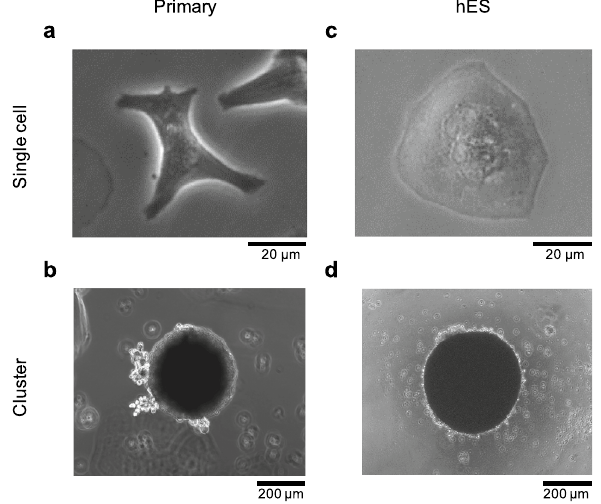
Figure 2. Micrographs of single cells and clusters of mouse primary and hES-derived cardiomyocytes. ( a ) Mouse primary cardiomyocytes (primary) in a 35-mm non-agarose-coated dish (single cell), ( b ) primary cells in a 24-well agarose-coated plate (cluster), ( c ) hES cardiomyocytes in a 35-mm non-agarose-coated dish (single cell), and ( d ) hES in a 24-well agarose-coated plate